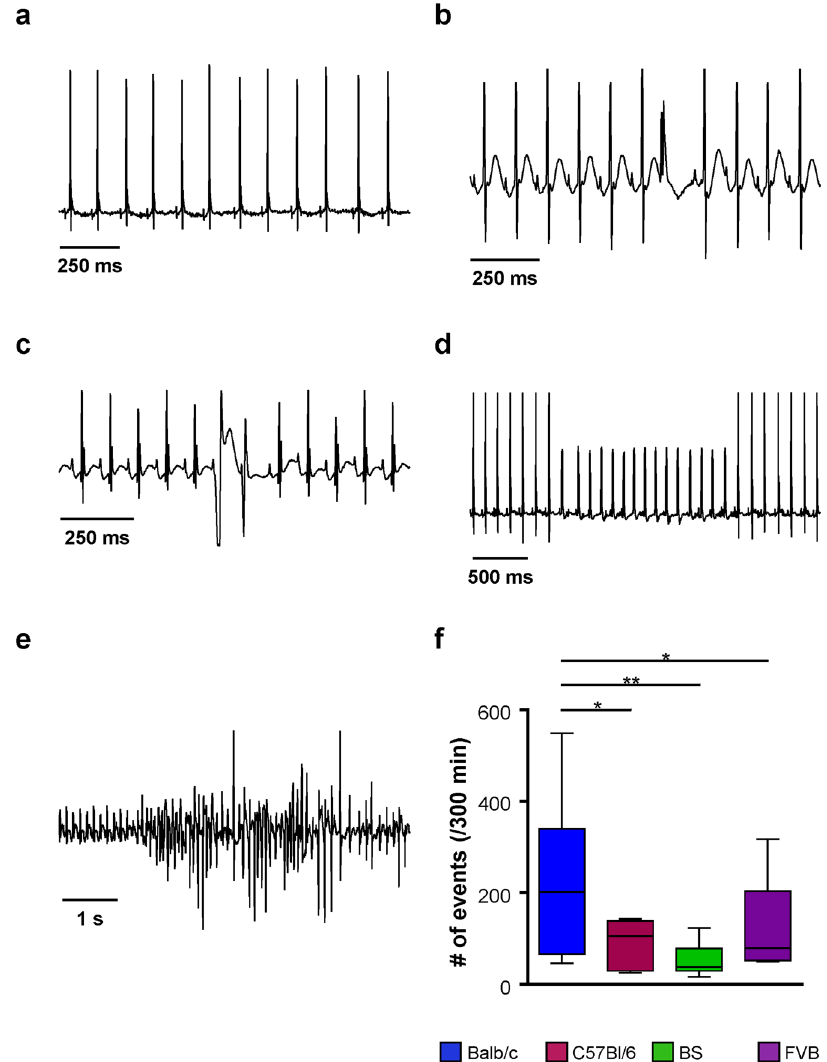
Figure 6. Representative ECGs and occurrence of ventricular arrhythmias under β -adrenergic stimulation. ( a ) Sinus rhythm, ( b ) premature ventricular beats (PVB), ( c ) coupled beats, ( d ) ventricular tachycardic events (VT) and ( e ) ventricular fibrillation events (VF). ( f ) Number of total arrhythmic events (sum of PVBs, coupled beats, VT and VF) over 5 hours following isoproterenol injection. Data are given as median and 5–95 percentile. Balb/c n = 6, C57Bl/6 n = 6, BS n = 6, FVB n = 5. * p < 0.05; ** p < 0.01 (multiple comparisons were calculated by Kruskal-Wallis test followed by Dunn’s post-hoc test).